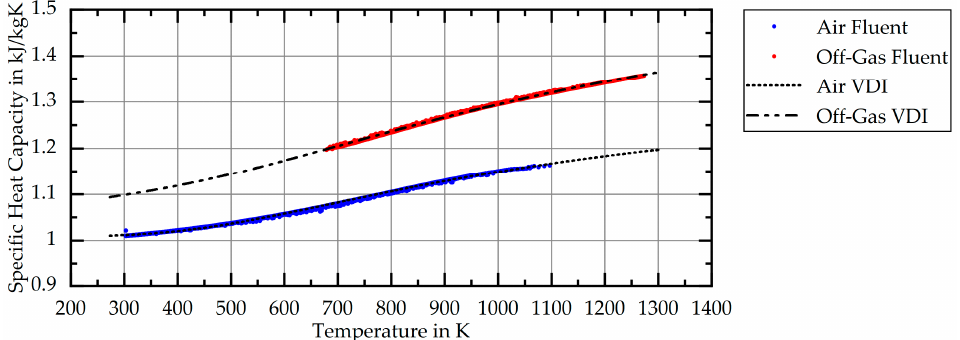
Figure A2. Sampled data points of the specific heat capacity of air and off-gas at λ = 1.15 calculated in ANSYS® Fluent in comparison with values calculated with methods described in [20].